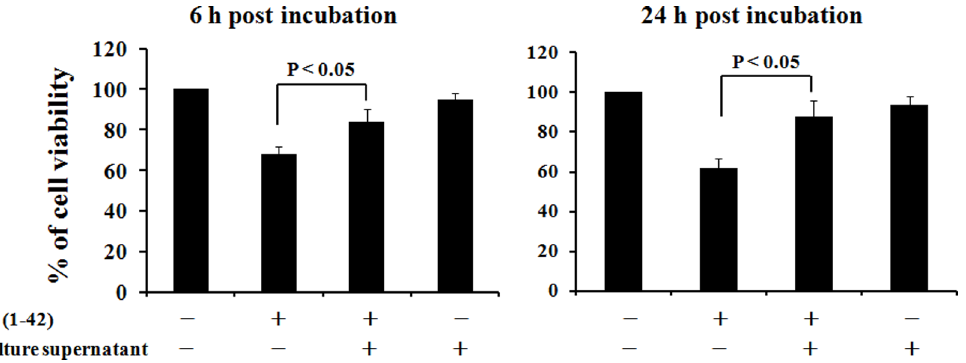
Figure 3. In vitro cytotoxicity inhibition test using primary culture hippocampal cells. The viability of primary hippocampal cells after 6– 24 h of culture with 10 uM aggregated Aß protein was examined. The effect of adding culture supernatant from Aß mAb - expressing AAV vector transduced cells was also examined by MTT assay. Data represent the results of 5–8 independently analyzed samples and are presented as mean 6 SE.